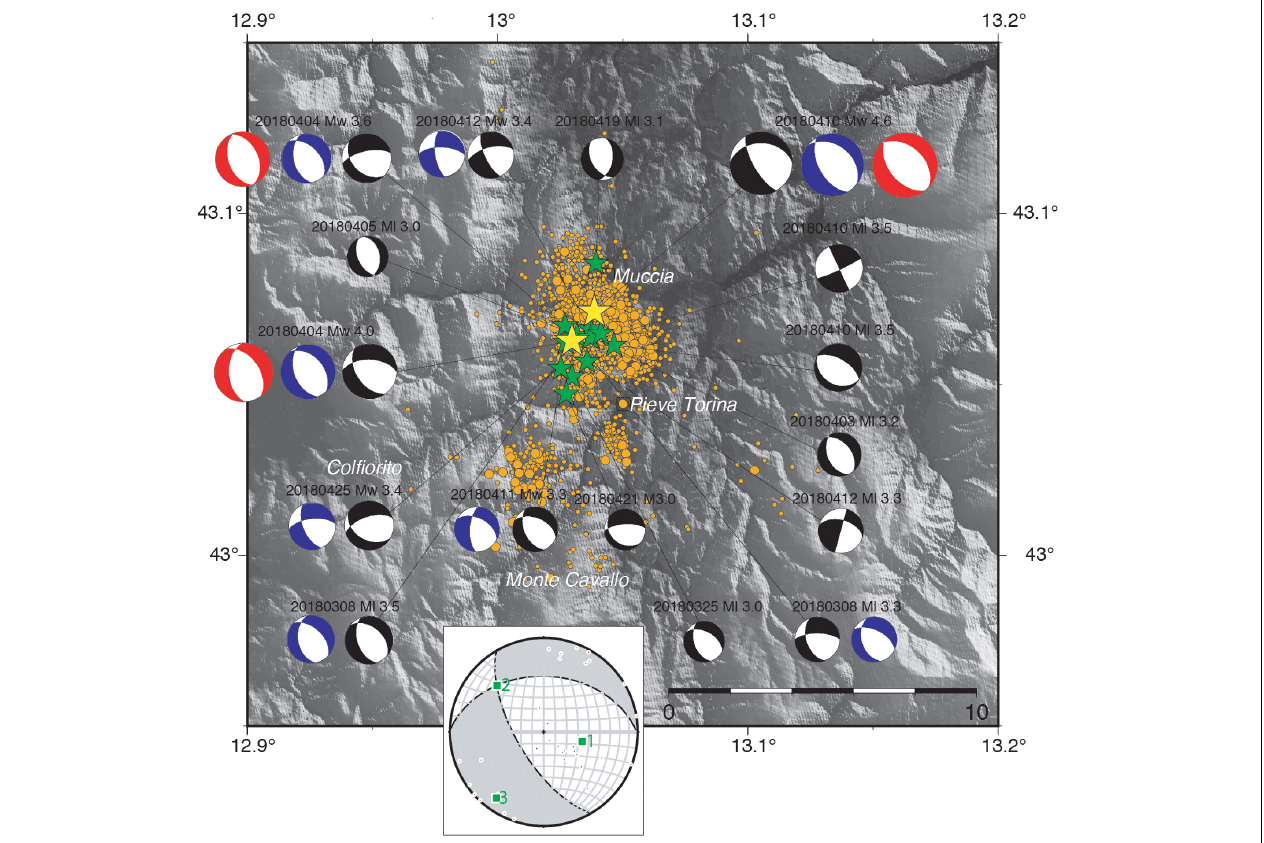
FIGURE 15 | Muccia area. Yellow stars are the M w ≥ 4.0 earthquakes, green stars the M w ≥ 3.0 earthquakes. Small orange dots are M ≥ 1.0; medium orange dots are M ≥ 2.0 earthquakes. The average focal mechanism obtained by unweighted moment tensor (Kassaras and Kapetanidis, 2018) has been calculated considering M ≥ 3.0 events. Red focal mechanisms are from RCMT (rcmt2.bo.ingv.it/); blue focal mechanisms are from TDMT